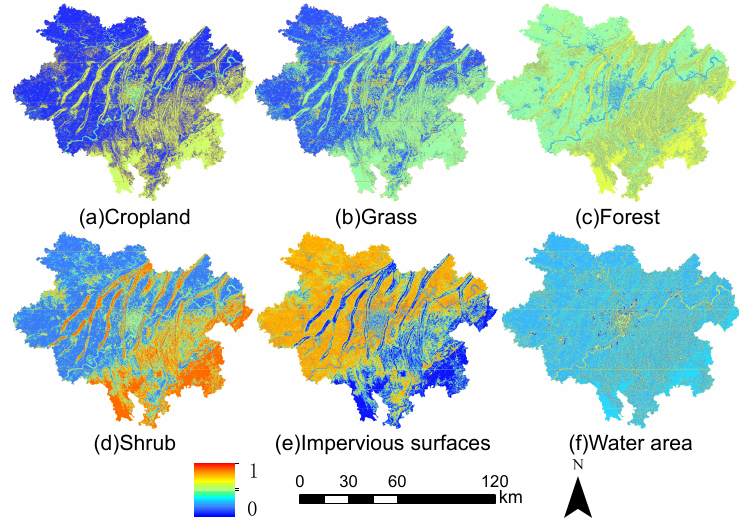
Figure 7. Neighborhood probability of conversion to six types of land from 2015 to